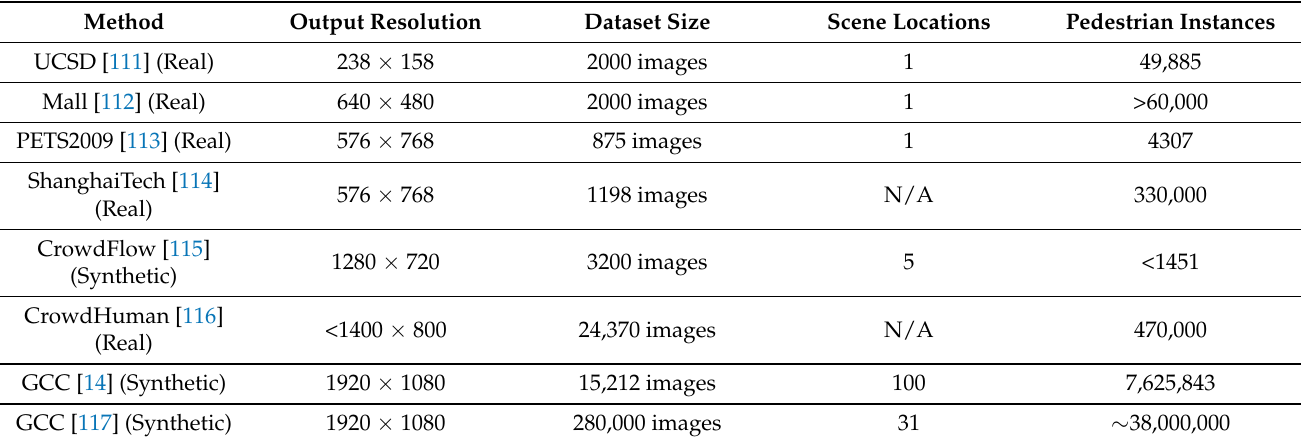
Table 2. Comparison of Real and Synthetic Datasets for Crowd